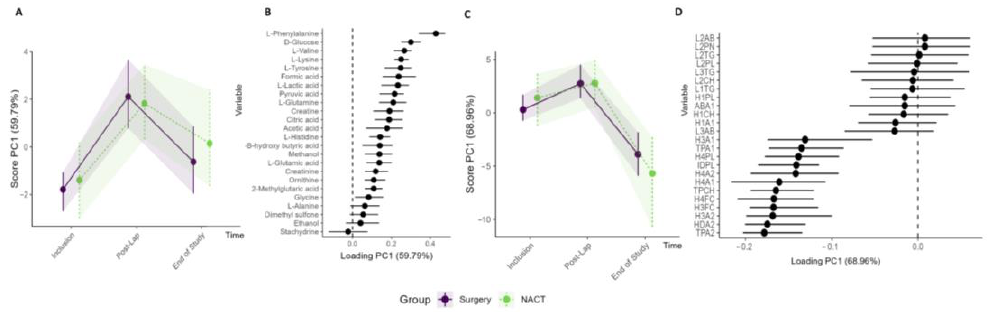
Figure 6. Subgroup analysis of Arm I (n = 15) primary cytoreductive surgery and Arm II (n = 9) NACT. RM–ASCA+ analysis showing the trajectories of metabolites ( A , B ) and lipoproteins ( C , D ) grouped into Arm I (purple) and Arm II (green). The inclusion, post-laparoscopy, and end-of-study time points are included in the analyses. Only the lipoprotein subfractions with the highest contribution to the PC1 are shown.